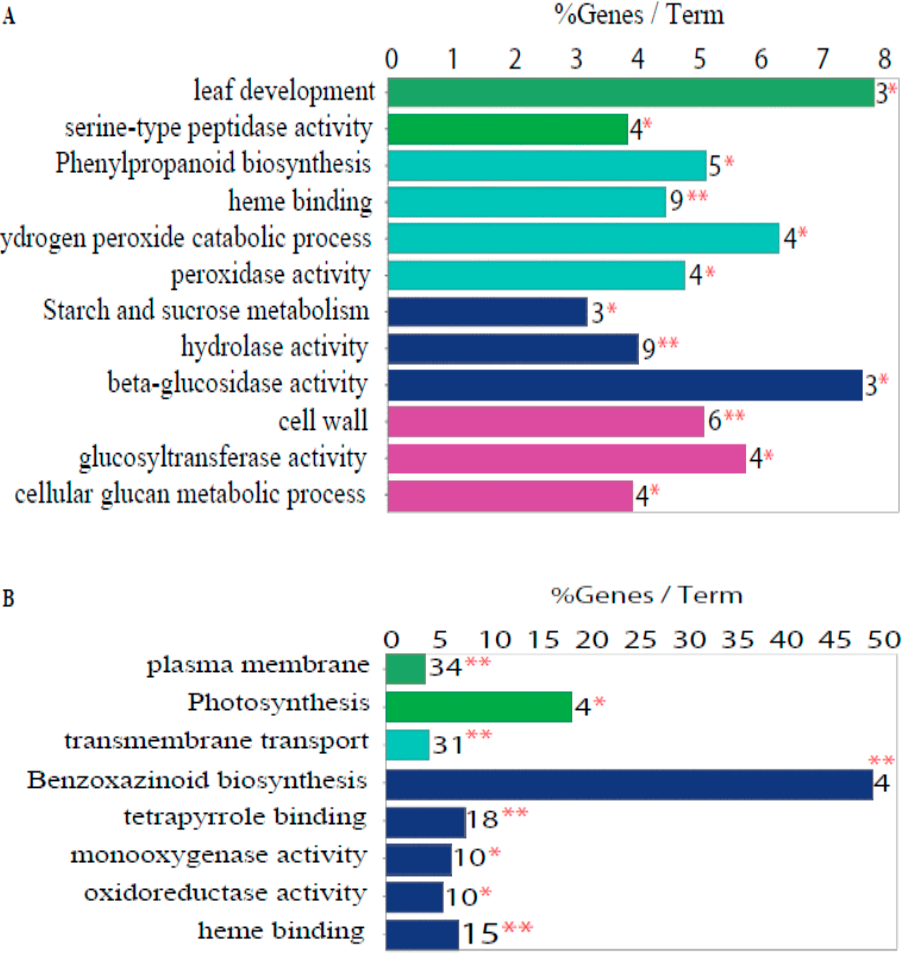
Figure 4. Enriched GO terms among DEGs. ( A ) GO terms enriched among DEGs more highly expressed in the female inflorescence (FI). ( B ) GO terms enriched among DEGs more highly expressed in the top internode of the stem (TI). A two-sided hypergeometric test was used to test for enrichment/depletion, Bonferroni step down correction method, kappa score 0.4. The enrichments show only significant GO terms, p -value: * 0.05, ** 0.01.